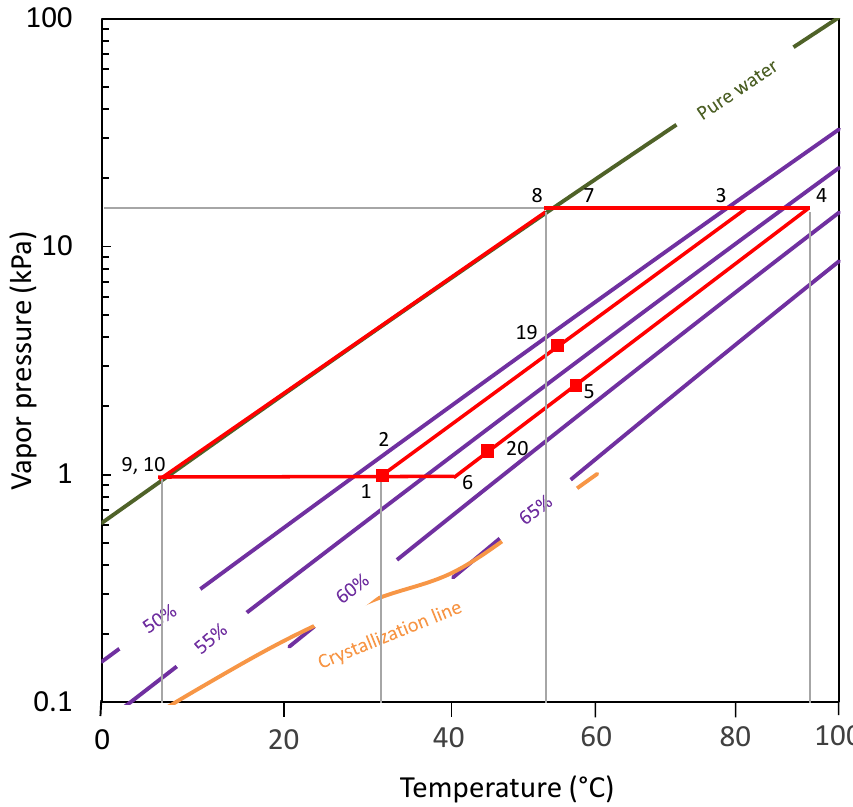
Figure 2. Dühring plot for the proposed single-effect H 2 O/LiBr absorption heat pump with conden- sation heat recovery.